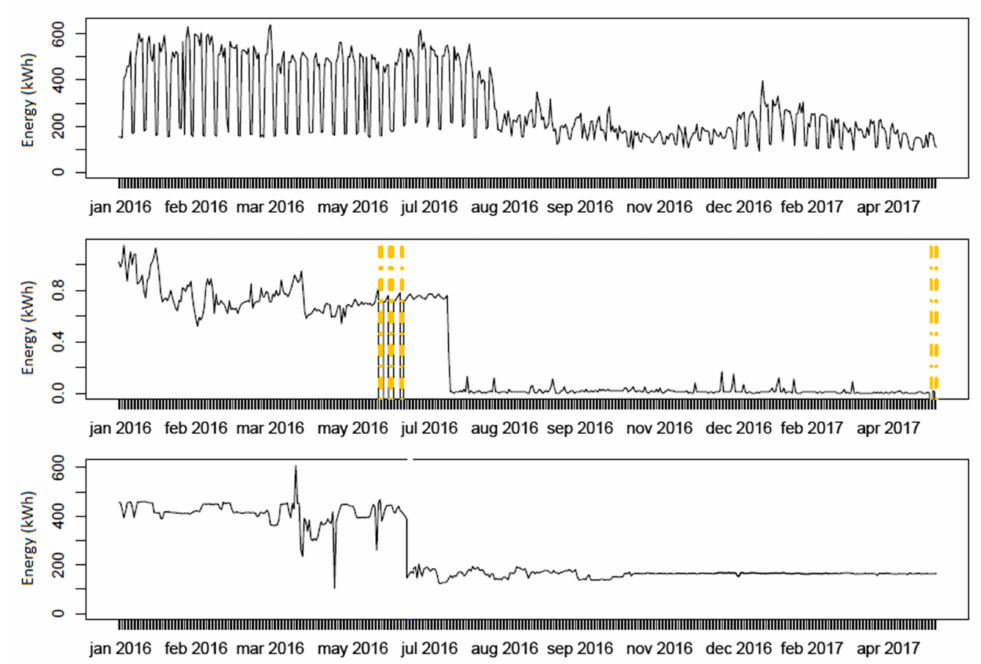
Figure 19. Three examples of anomalous detection (large scale